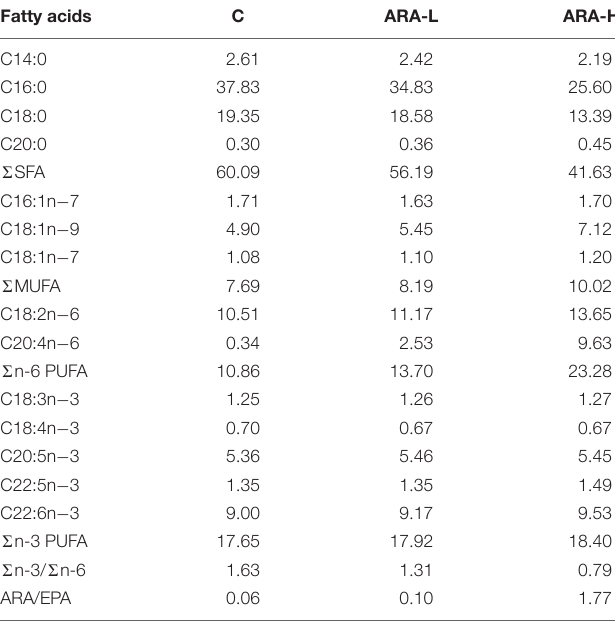
TABLE 2 | Fatty acids composition of experimental diets (% total fatty acids).